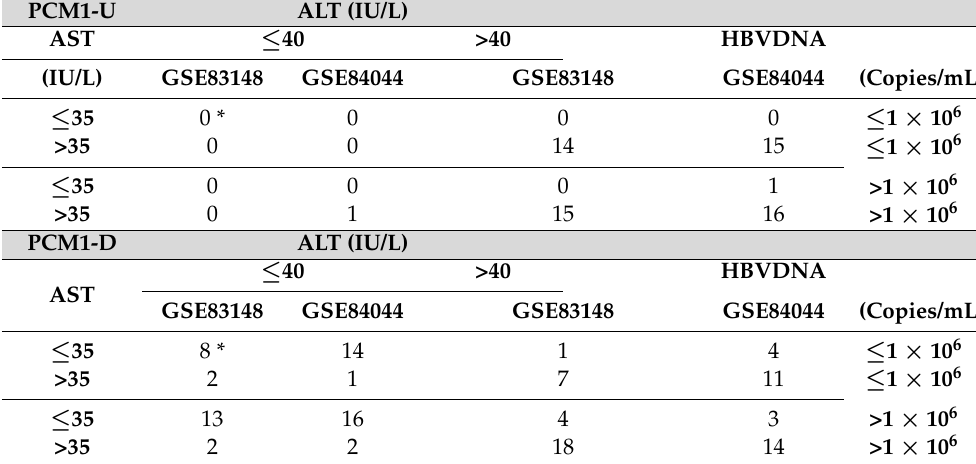
Table 1. Clinical characteristics of PCM1 ‐ U and PCM1 ‐ D patients.